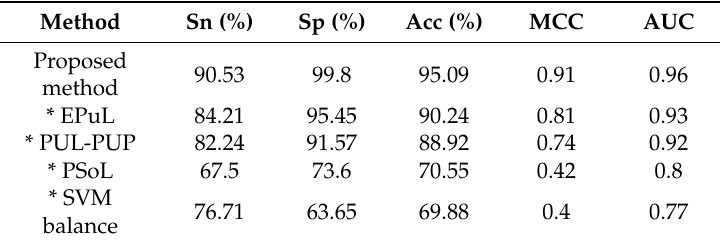
Table 3. Comparison of the proposed method with EPuL, PUL-PUP, PSoL, and support vector machine (SVM) balance on 10-fold cross-validation